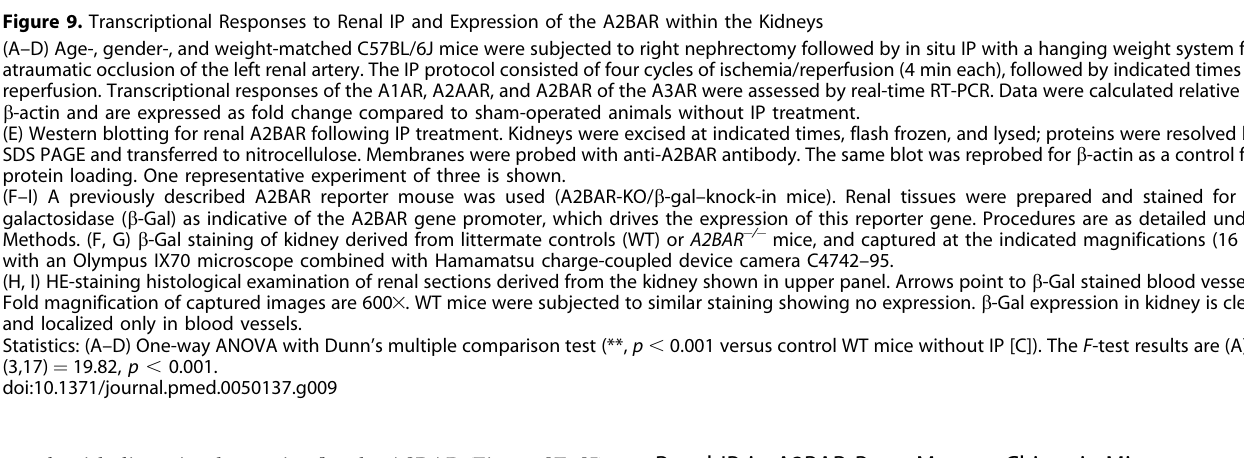
renal epithelia stained negative for the A2BAR (Figure 9F–9I).